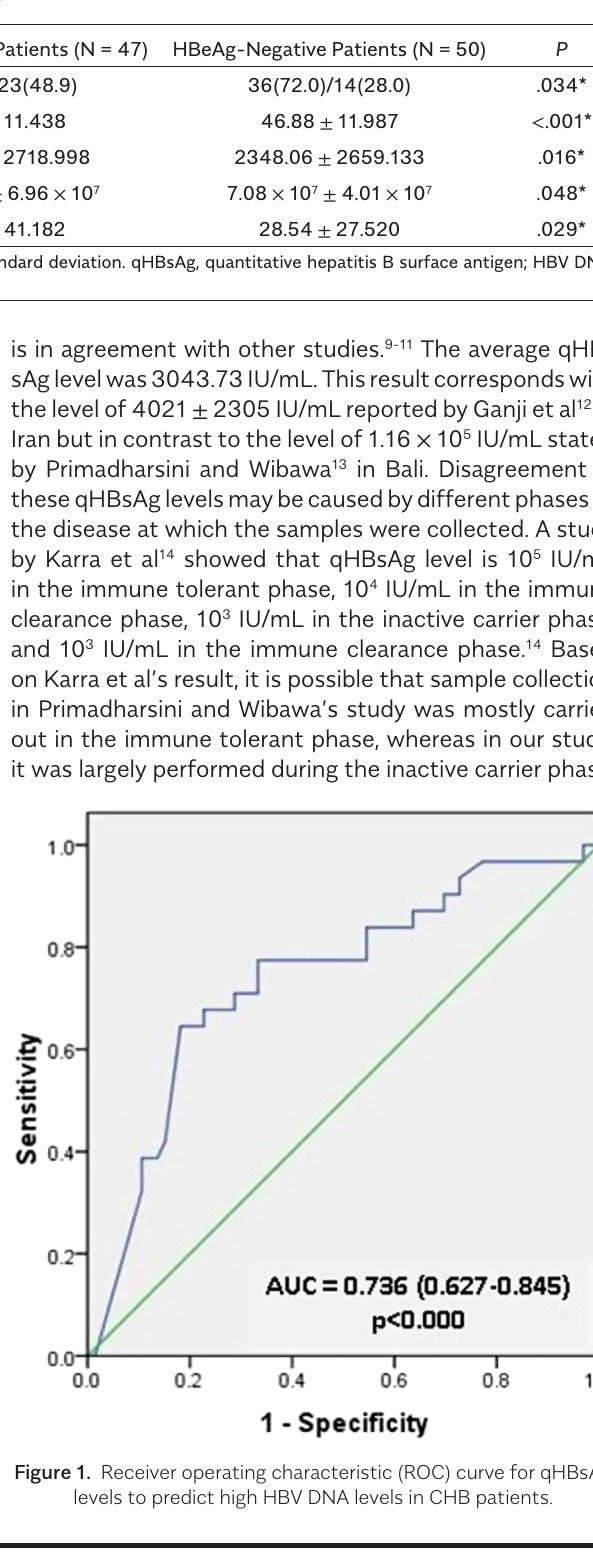
Figure 1. Receiver operating characteristic (ROC) curve for qHBsAg levels to predict high HBV DNA levels in CHB